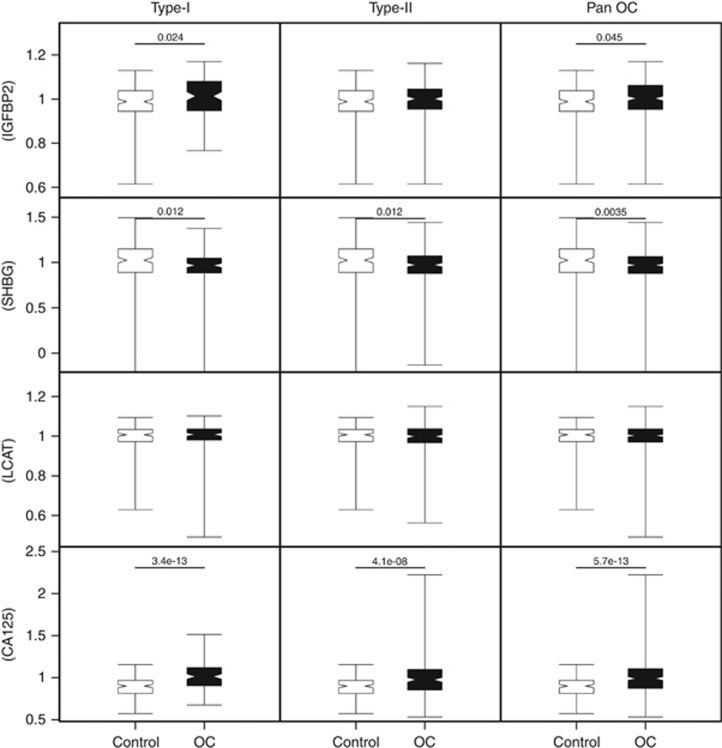
Comparison of putative biomarker expression in pre-diagnosis sets with no division by tDx. The whisker limits represent the 5th and 95th percentiles; the box limits represent interquartile range; the closest point in the notches (><) of the box plot represents the median and the span from the bottom to the top of the notch is 95% confidence interval (for significant values between cases and controls it can be seen that these do not overlap). Significant P-values are indicated on the plot.